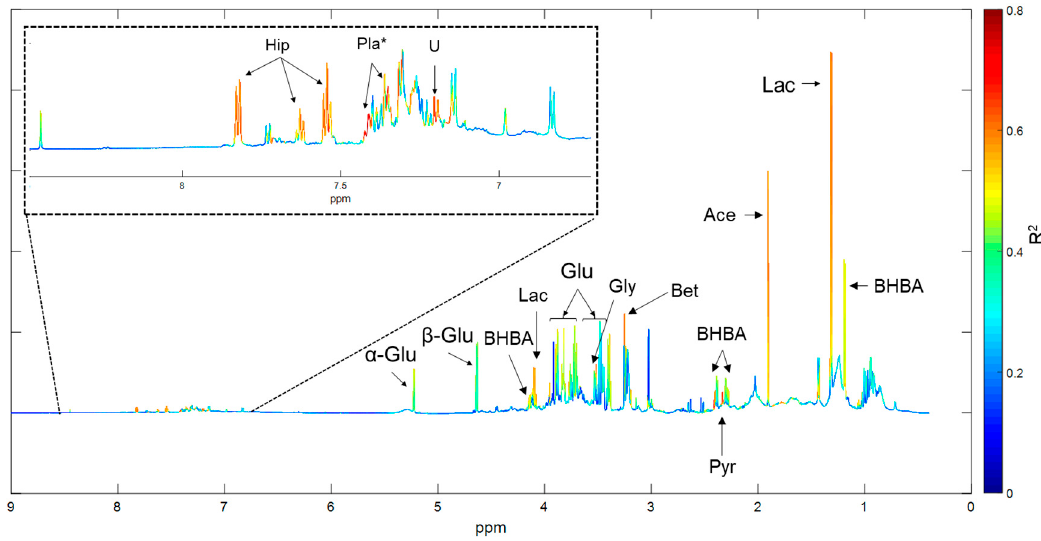
Figure 4. Average 1 H NMR spectrum of bovine serum. Color coding represents the percentage of variation in the signal at each chemical shift intensity that can be explained by herd of origin. The δ 6.5 to 8.5 region has been magnified for clarity purposes. Ace = acetate, Bet = betaine, BHBA = β hydroxybutyrate, Gly = glycine, Hip = hippurate, Lac = lactate, Pla = 3-phenyllactate, Pyr = pyruvate, U = unidentified peak. * indicates tentative